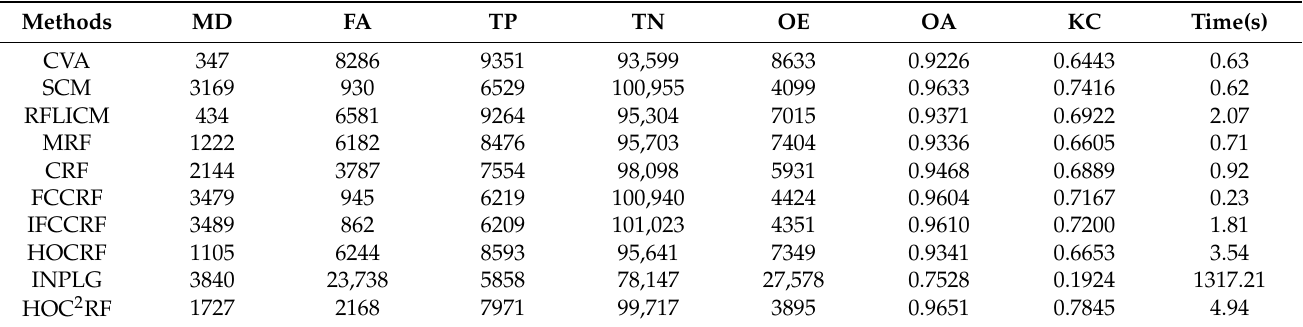
Table 5. Quantitative indicators for CD maps on the Poyang River